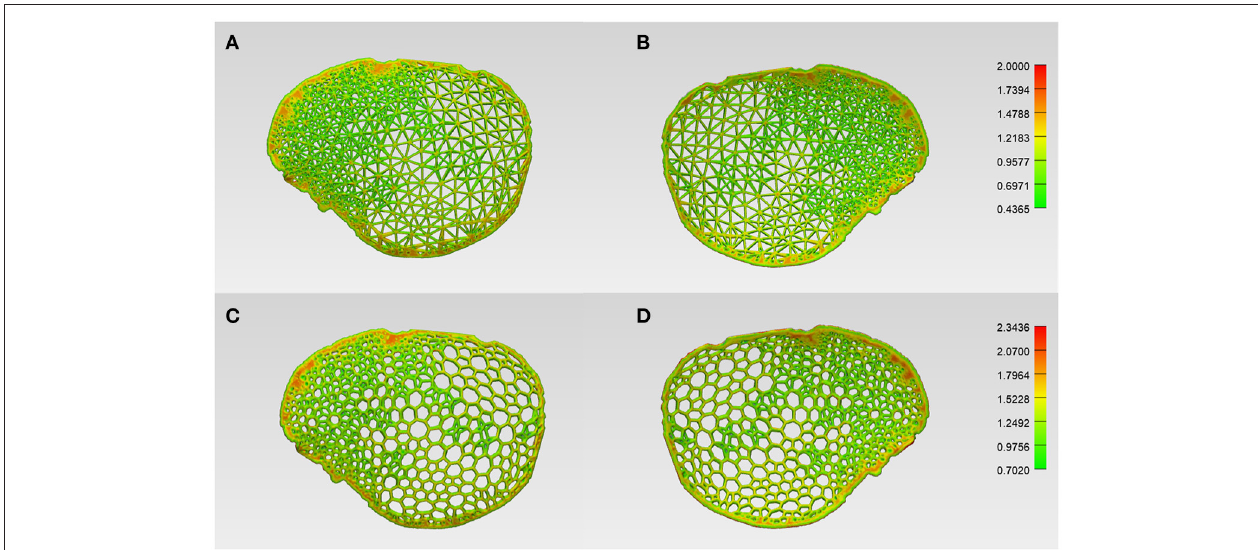
FIGURE 5 | Color-coded maps illustrating the wall/strut thickness of the respective designs of the customized cranial prosthesis. (A) Wireframe/lattice Voronoi pattern prosthesis squamous (external) view. (B) Wireframe pattern prosthesis cerebral (internal) view. (C) Organic Voronoi pattern prosthesis squamous (external) view. (D) Voronoi pattern prosthesis cerebral (internal) view.